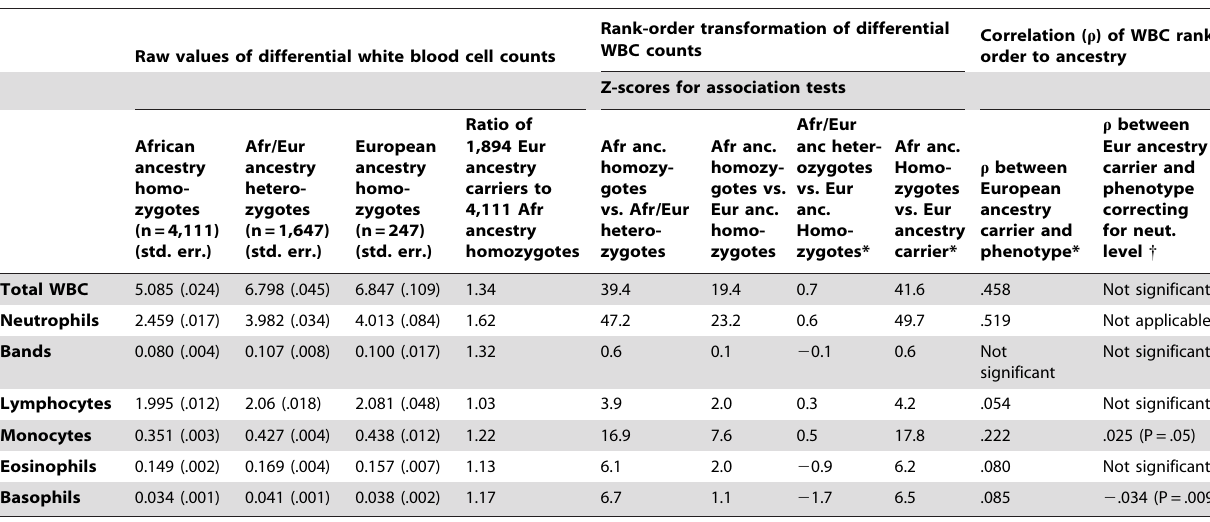
Table 2. Effect of the chromosome 1 locus on white blood cell counts.